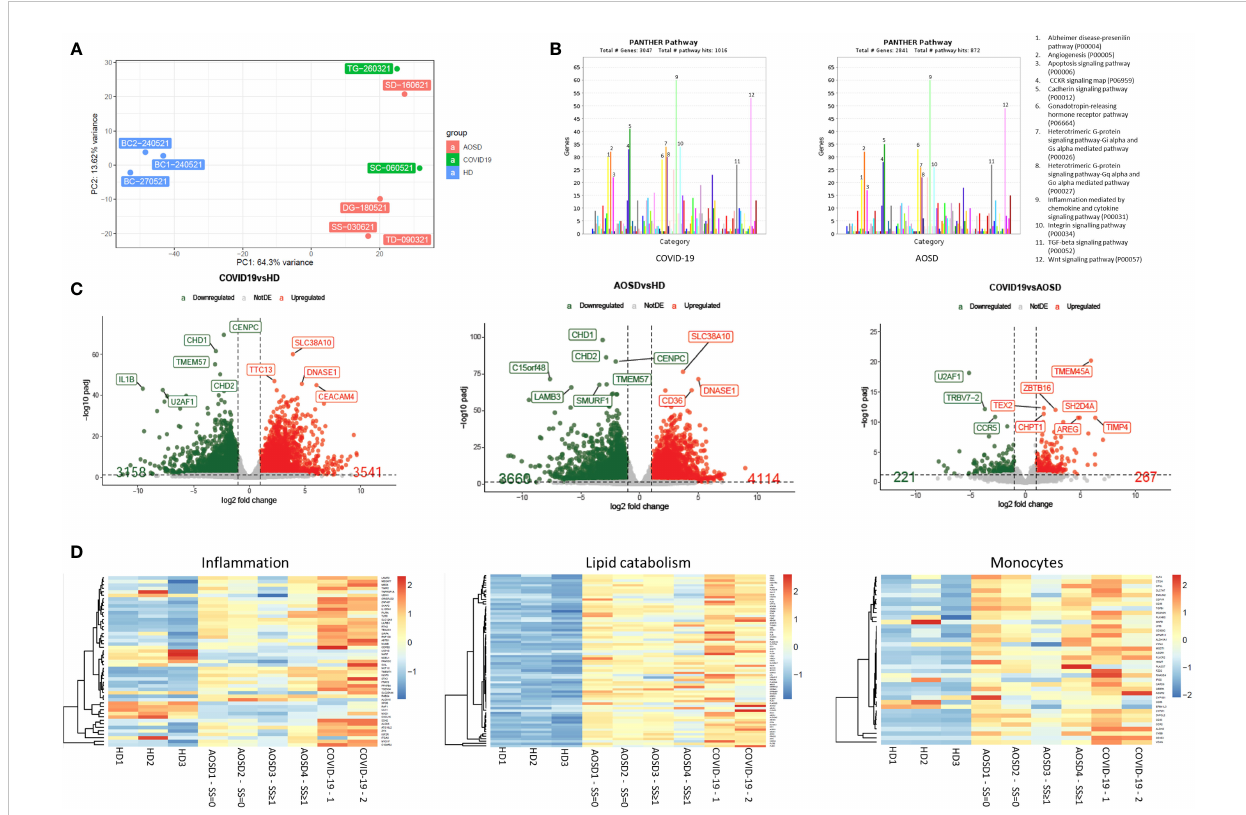
FIGURE 1 Transcriptome analysis of peripheral immune cells from HDs, COVID-19 and AOSD patients. (A) PCA plot. PCA shows the sample in the 2D plane spanned by their fi rst two principal components. (B) Pathway analysis by Pantherdb.org. Bar chart of enriched pathways in COVID19 and AOSD patients. (C) Volcano plots. Volcano plot representation of differential expression analysis of genes in COVID-19 vs HD, AOSD vs HD, and COVID-19 vs AOSD. Red and green points mark the genes with signi fi cantly increased or decreased expression (FDR<0.05). The x-axis shows log2fold-changes in expression and the y-axis the log odds of a gene being differentially expressed. (D) Transcriptome analysis from 3 HDs, 2 COVID-19 patients and 3 AOSD patients of genes involved in in fl ammation, lipid catabolism and monocytes. HD, healthy donors; AOSD, Adult-onset Still ’ s